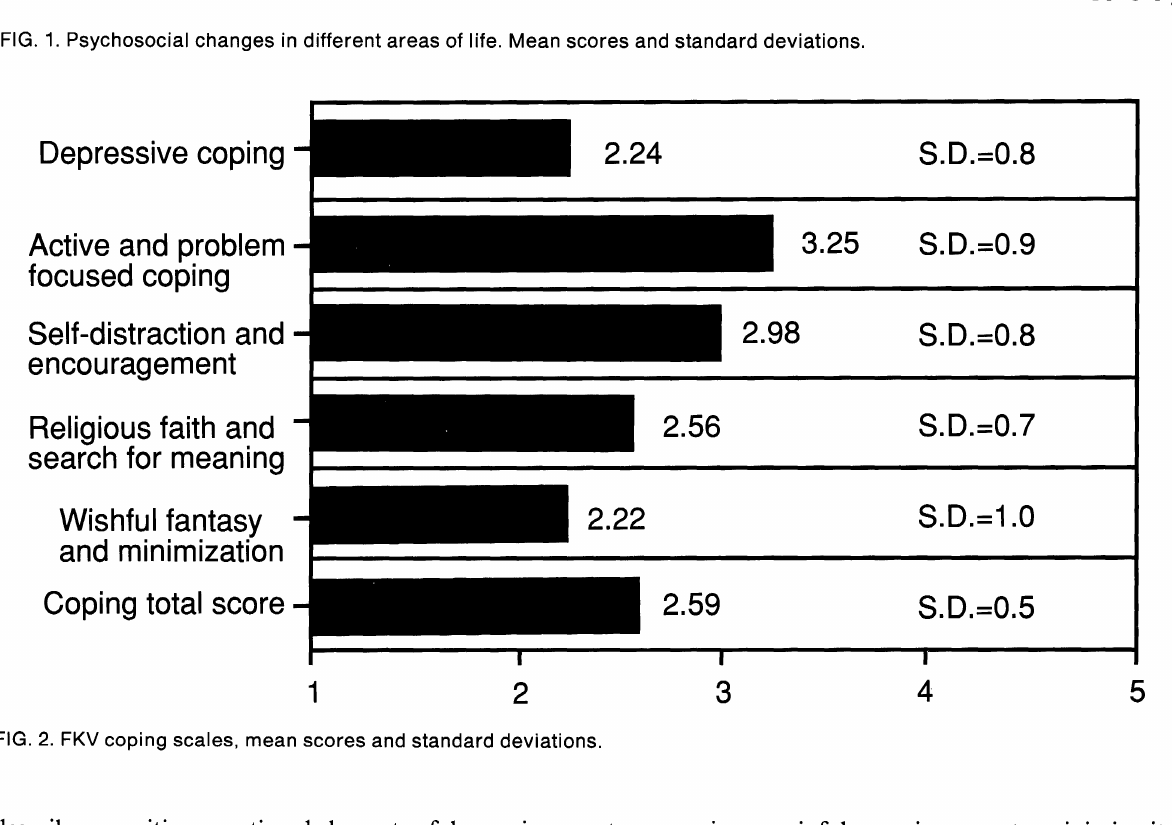
describes cognitive-emotional elements of depression. The scale minimization and wishful thinking com prises cognitive defence strategies such as not